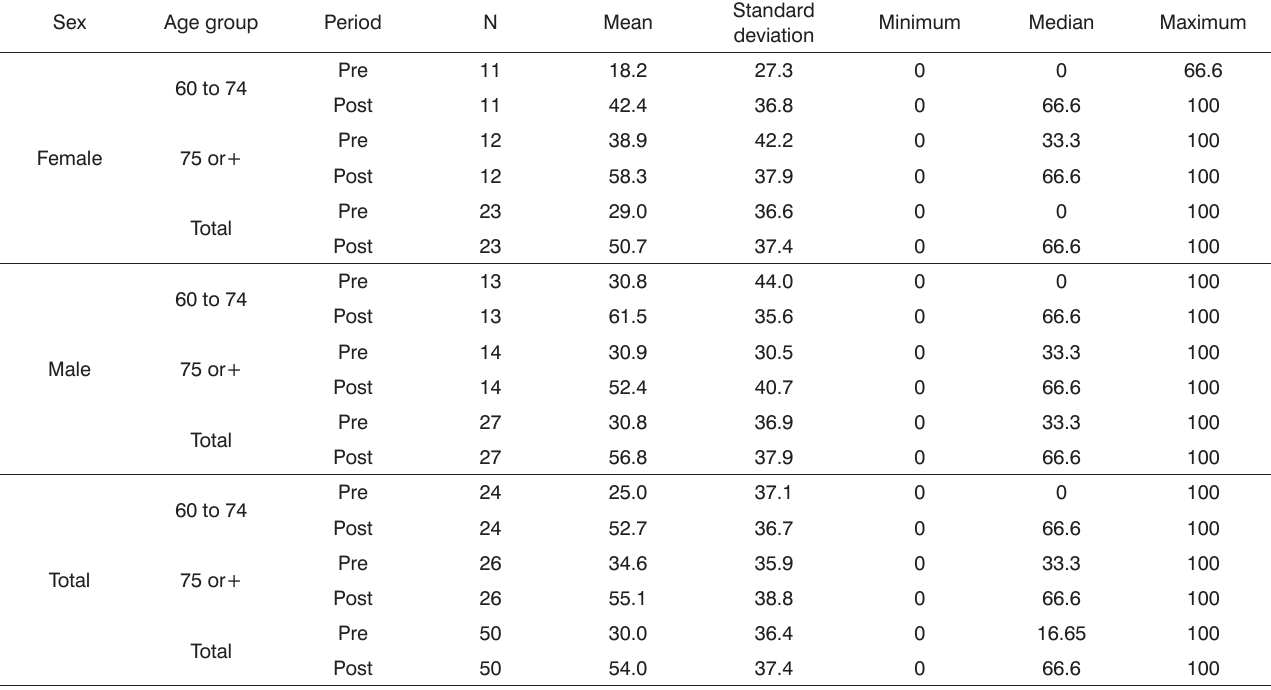
Table 10. Analysis of variance and descriptive statistics for the mental health aspect according to sex and age group.